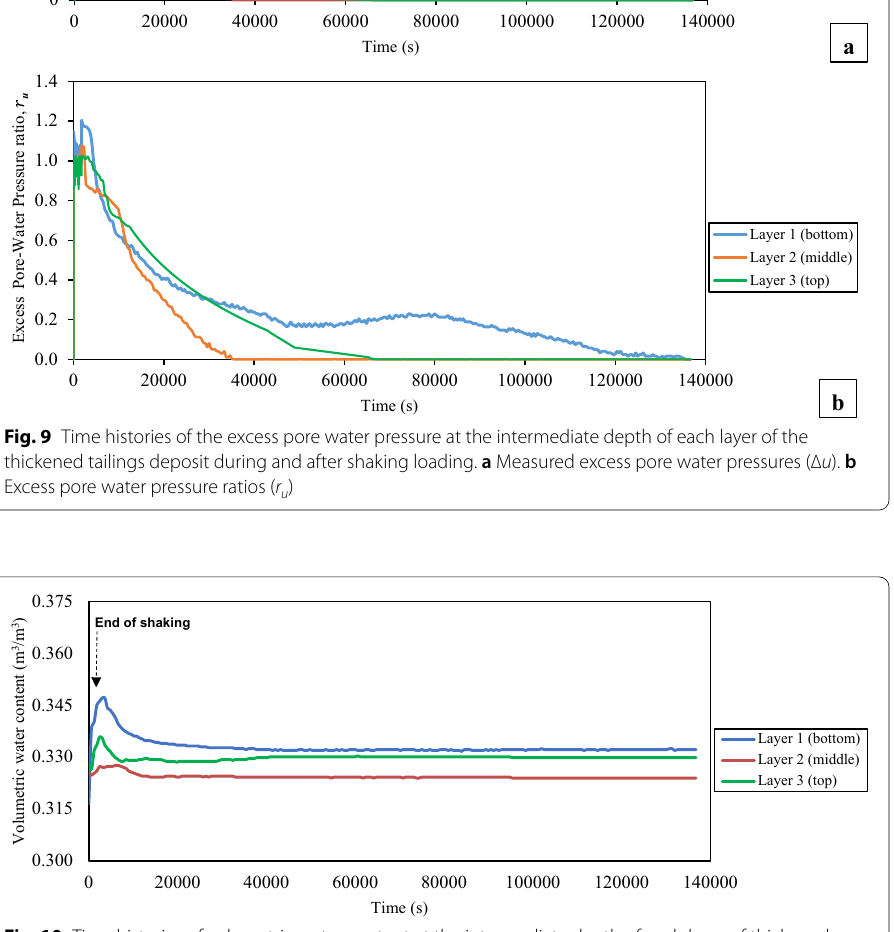
Fig. 10 Time histories of volumetric water content at the intermediate depth of each layer of thickened tailings deposit during and after